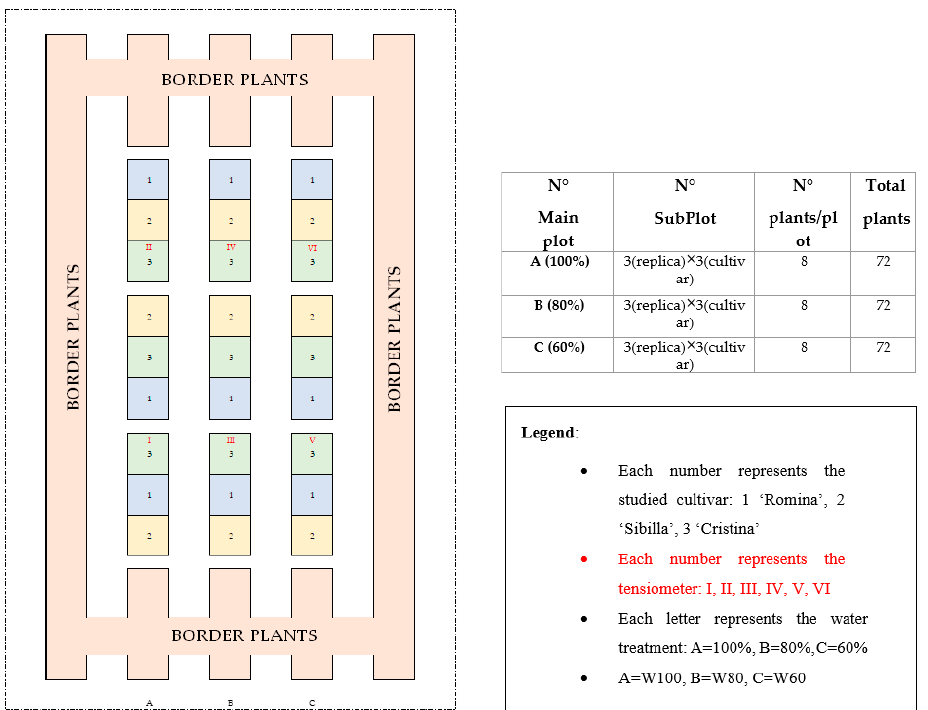
Figure 1. Experimental design. Table 2. Amount of water restitution during each cultivation cycle for the three treatments: W100 = 100% of water restitution; W80 = 80% of water restitution with respect to the standard (W100); W60= 60% of water restitution with respect to the standard (W100).